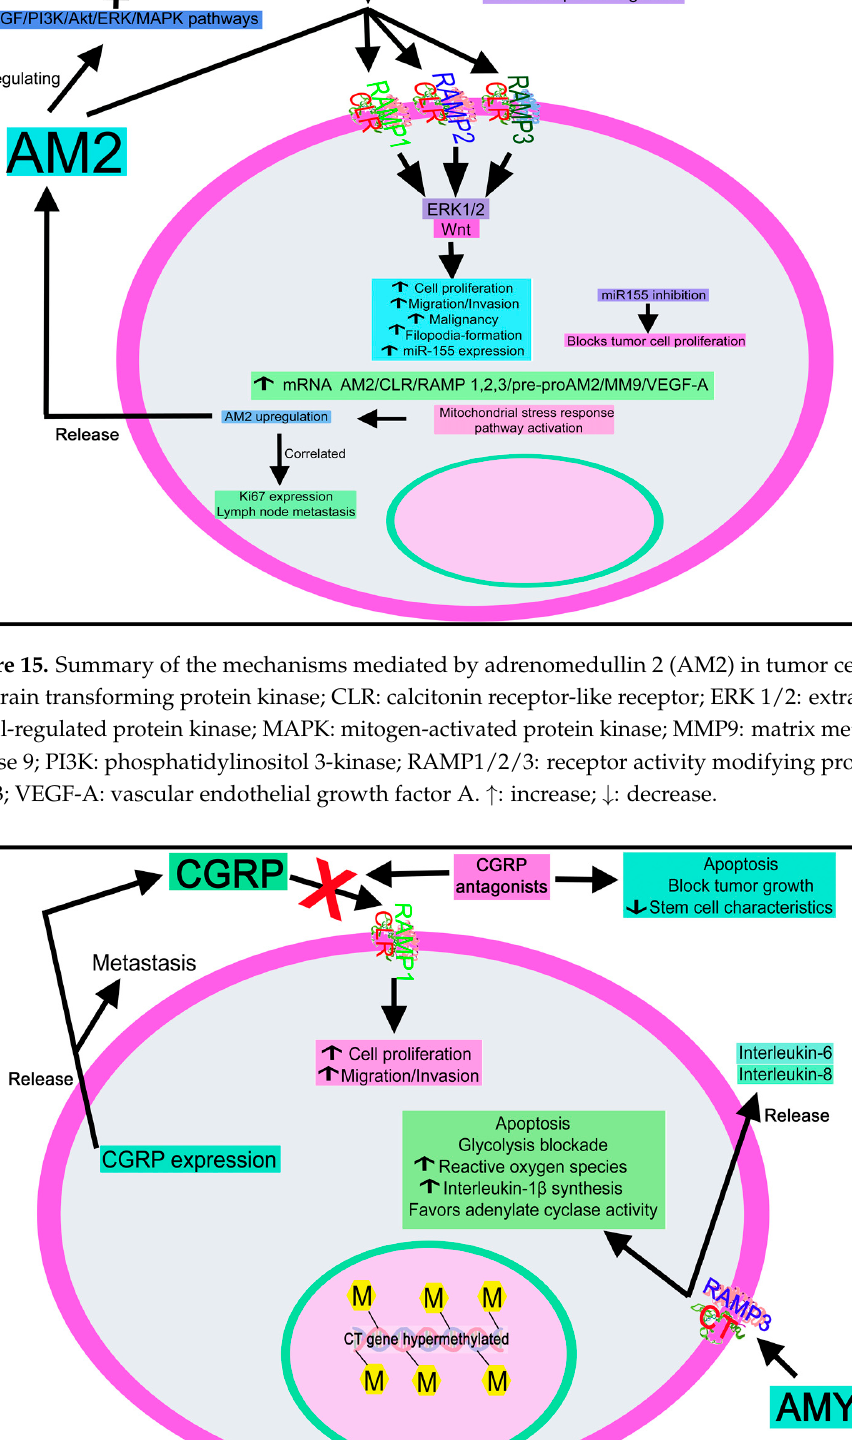
Figure 16. Summary of the mechanisms mediated by amylin (AMY) and calcitonin gene-related peptide (CGRP) in tumor cells. CLR: calcitonin receptor-like receptor; RAMP1/3: receptor activity modifying proteins 1 and 3. ↑ : increase; ↓ : decrease.